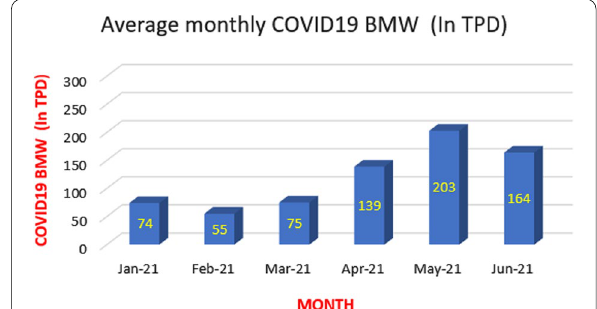
Fig. 3 COVID-19 related bio-medical waste generation